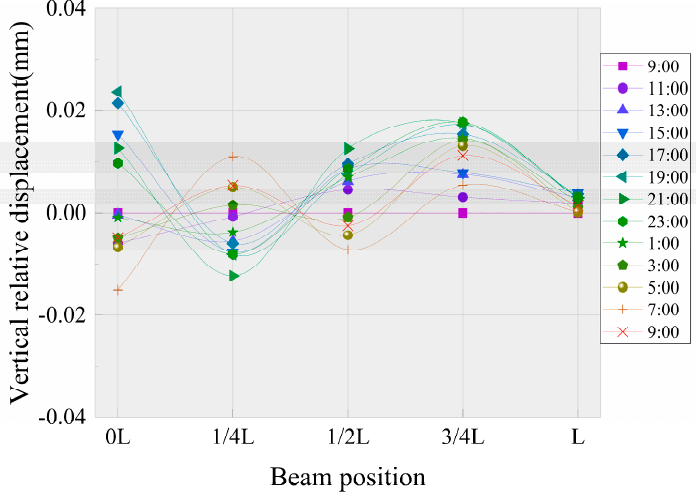
Figure 9. The displacement between the track slab and base slab.